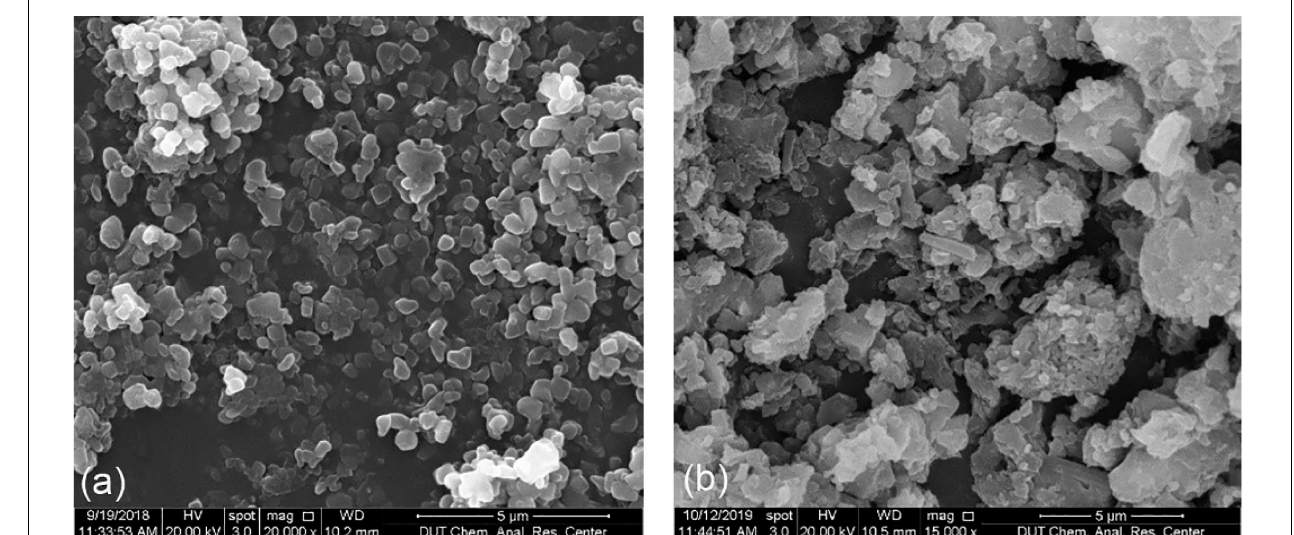
FIGURE 1 | FE-SEM images of (a) sterosomes; (b) CYM-loaded sterosomes. Scale bar = 5 µ